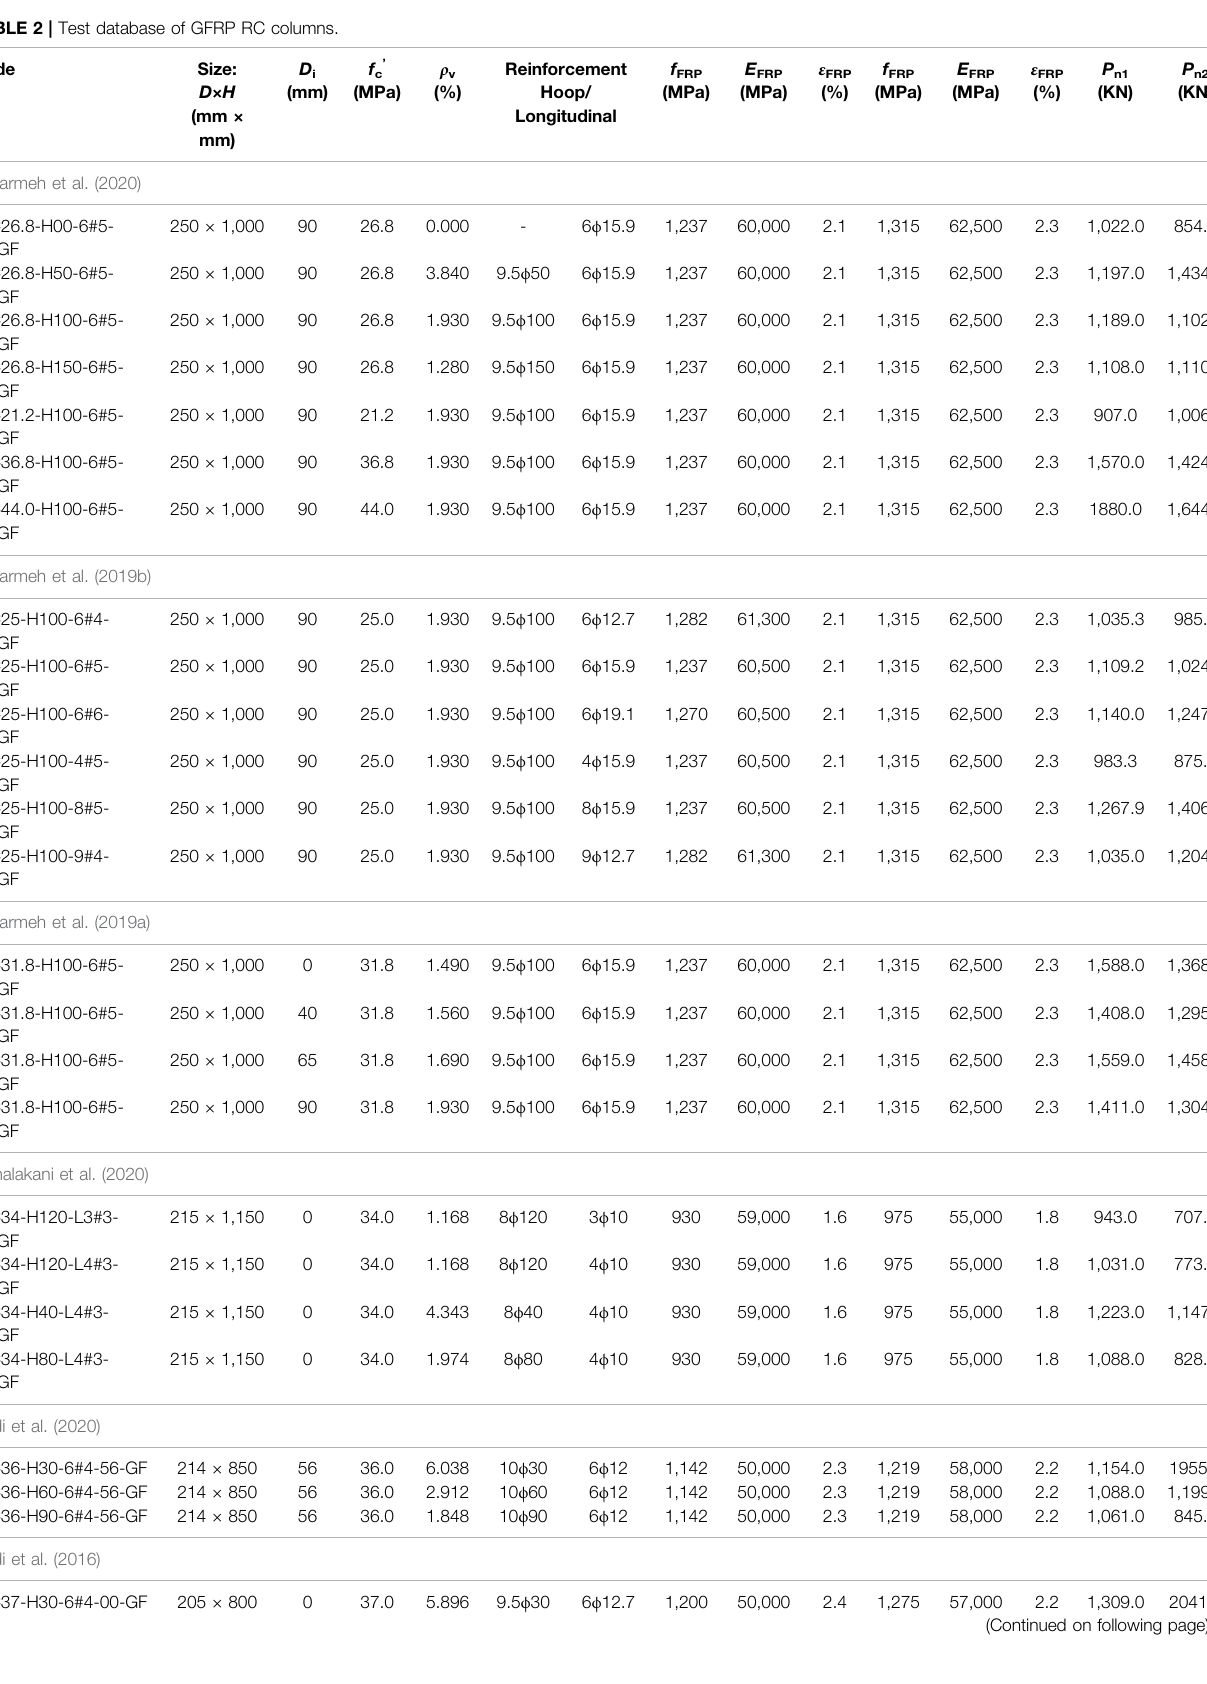
TABLE 2 | Test database of GFRP RC